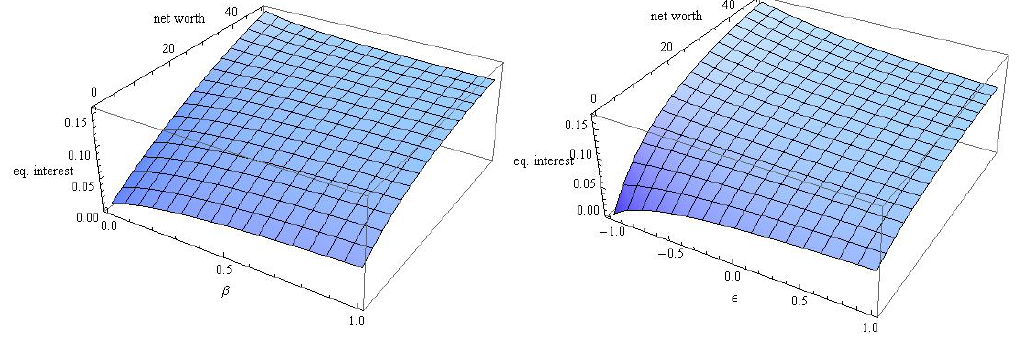
Figure 9: Interest